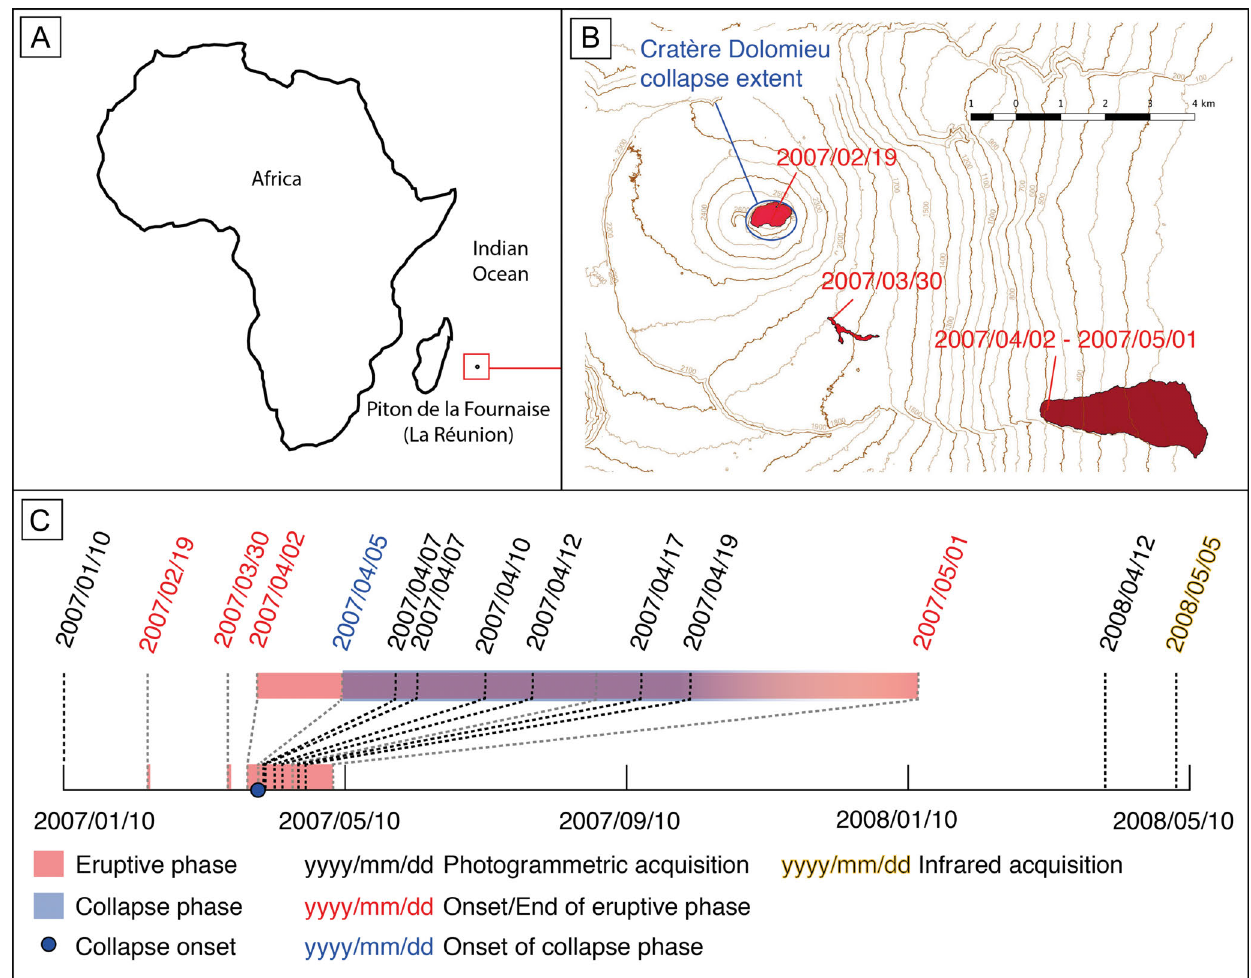
Figure 1: [A] Location of Piton de la Fournaise volcano. [B] Location of the April 2007 Cratère Dolomieu collapse and maps of the 2007 lava flows. [C] Timeline of the Piton de la Fournaise activity (eruptions and collapse) during the period of study. The dates of the aerial surveys used in this study are also